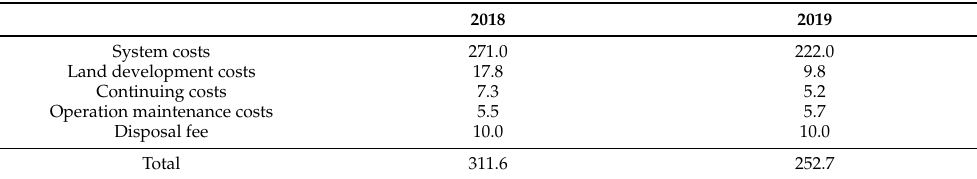
Table 2. Installation and operation costs (median) for solar power systems of more than 1 and